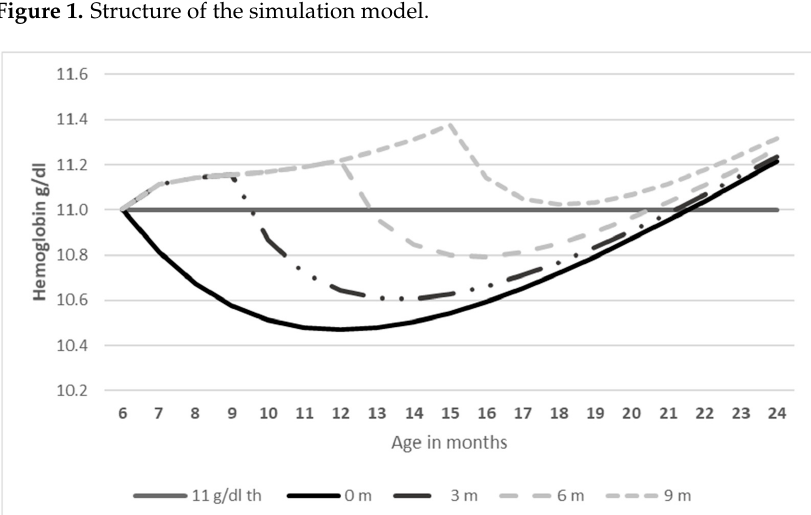
Figure 1. Structure of the simulation model.